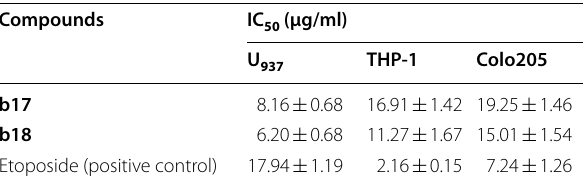
Table 22 Cytotoxicity of compound b20 Compounds